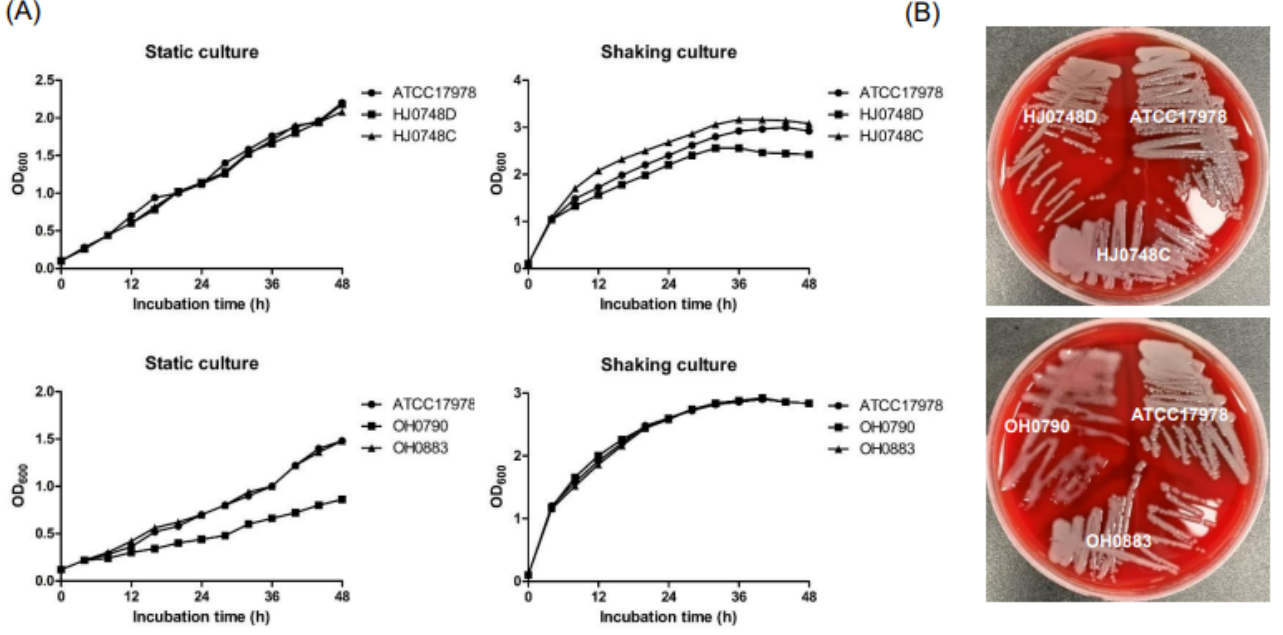
Figure 1. Growth kinetics and capsule production by Δ bfmR and Δ bfmS mutant strains. ( A ) A. baumannii ATCC 17,978 (wild-type), HJ0748D ( ∆ bfmR mutant) HJ0748C ( bfmR -complemented strain), OH0790 ( Δ b fmS mutant), and OH0883 ( bfmS -complemented strain) were grown in LB under either shaking or static conditions for 48 h and the OD 600 was determined at the indicated time points. The data are representative of two experiments with similar results. ( B ) A. baumannii strains were grown on blood agar plates for 24 h.